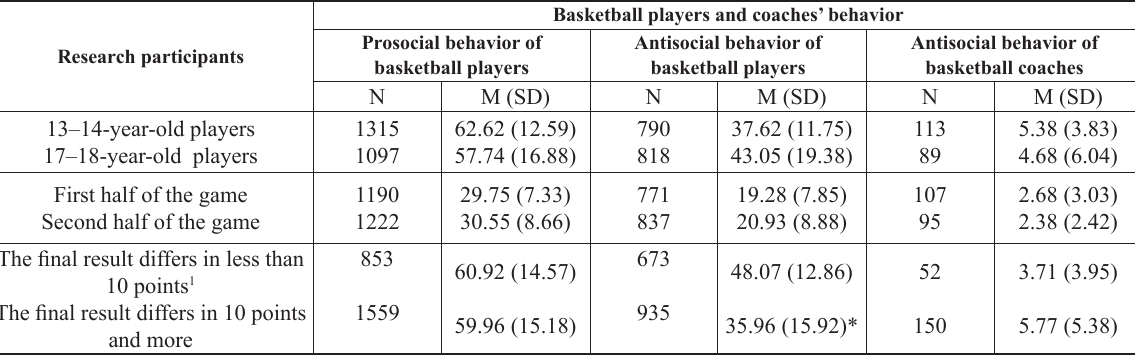
Table 1. Absolute and mean frequency values of basketball players and coaches’ behavior during the game in the aspect of the players’ age, the course of the game and final